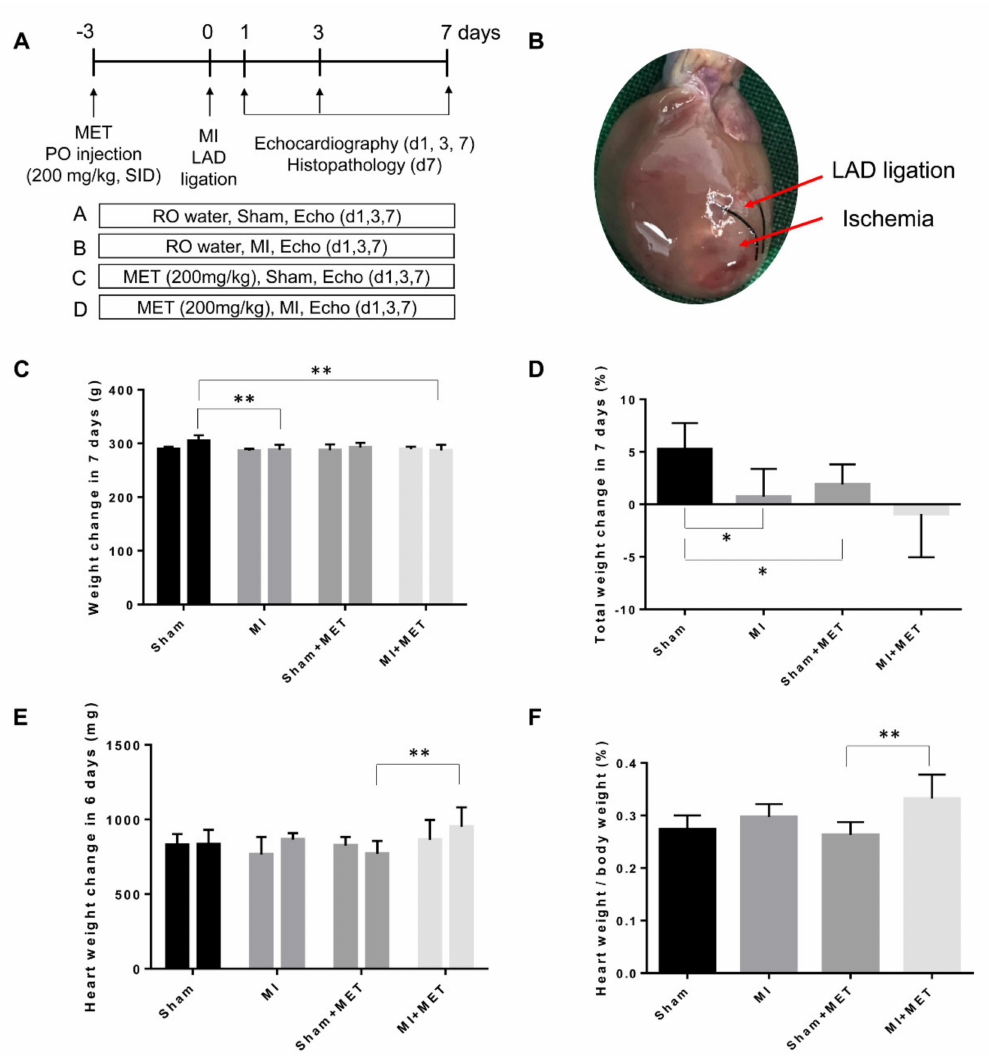
Figure 1. Experimental design using a rat myocardial infarction / reperfusion injury model. ( A ) The animals were divided into four groups: Group A, Sham; Group B, MI; Group C, Sham + MET; Group D, MI + MET. ( B ) Representative gross photograph of a heart 7 days after MI surgery. ( C ) Body weight change in 7 days. ( D ) Di ff erences in total body weight change in 7 days. ( E ) Heart weight change in 6 days. ( F ) Heart weight / body weight (%) on Day 7. * indicates a statistically significant di ff erence compared with the Sham group by two-sample t -test ( p < 0.05). ** indicates a statistically significant di ff erence compared with the Sham group ( p < 0.01) by two-tailed unpaired t-test ( D , F ) and Tukey’s multiple comparisons test ( C , E ). LAD, left anterior descending; MET, metformin; MI, myocardial infarction; PO, per oral; RO, reverse